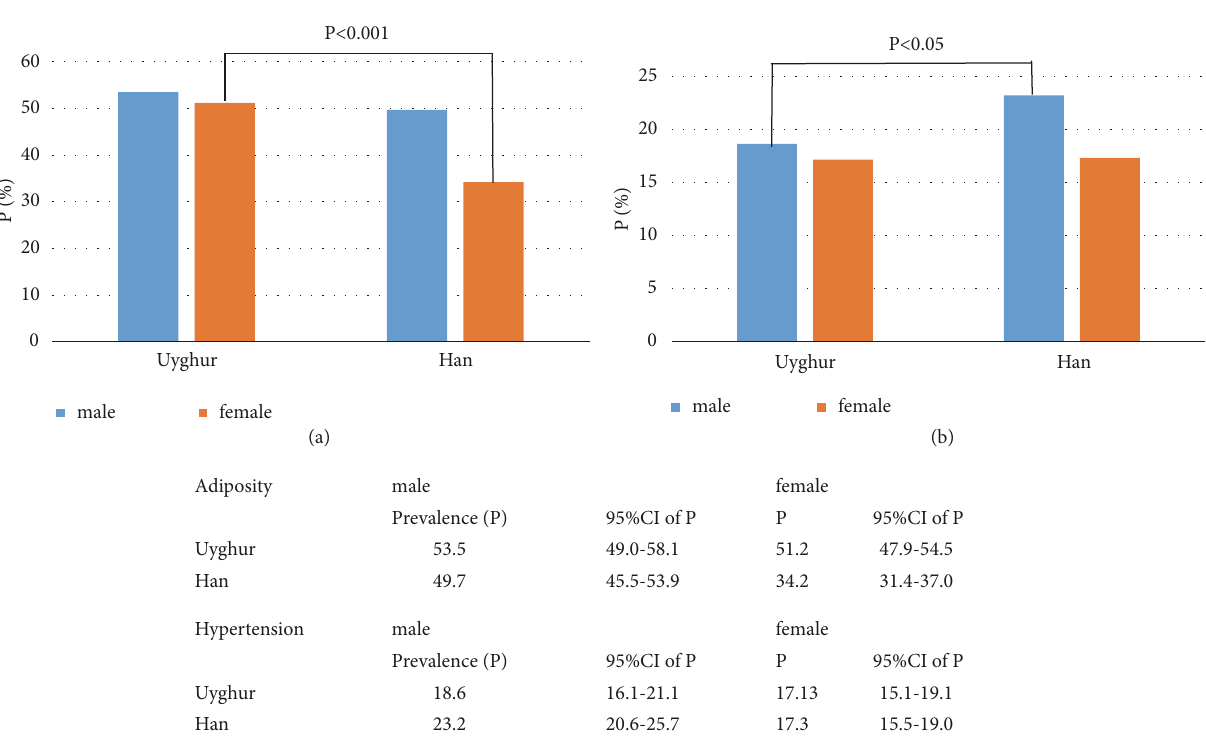
Figure 1: The sex specific prevalenceof overweight/obesityand hypertension in Uyghur and Han adults. (a) Adiposity (defined as overweight or obesity); (b) hypertension; Pc: crude prevalence; Ps: standardized